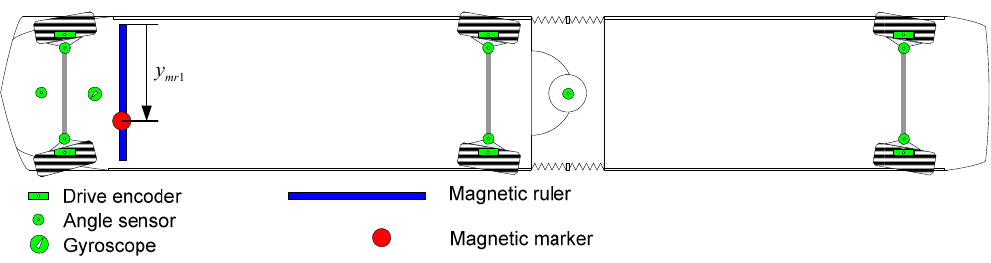
Figure 5. Sensors installed in the test vehicle.